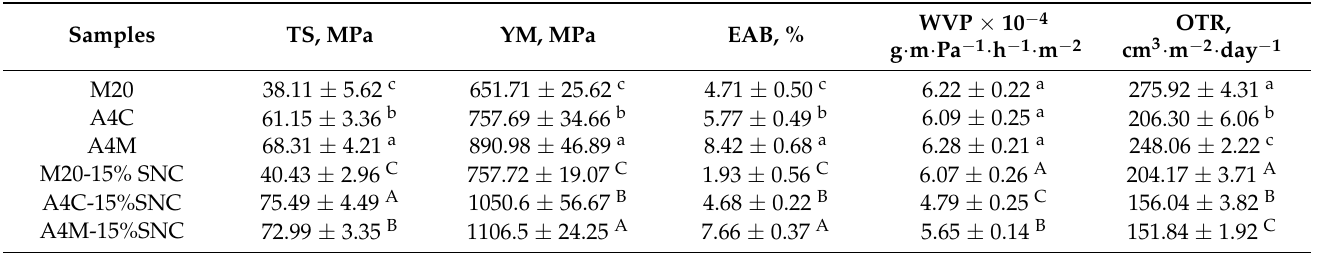
Table 3. Tensile strength, Young’s modulus, elongation at break, water vapor permeability, and oxygen transmission rate of MC film with and without